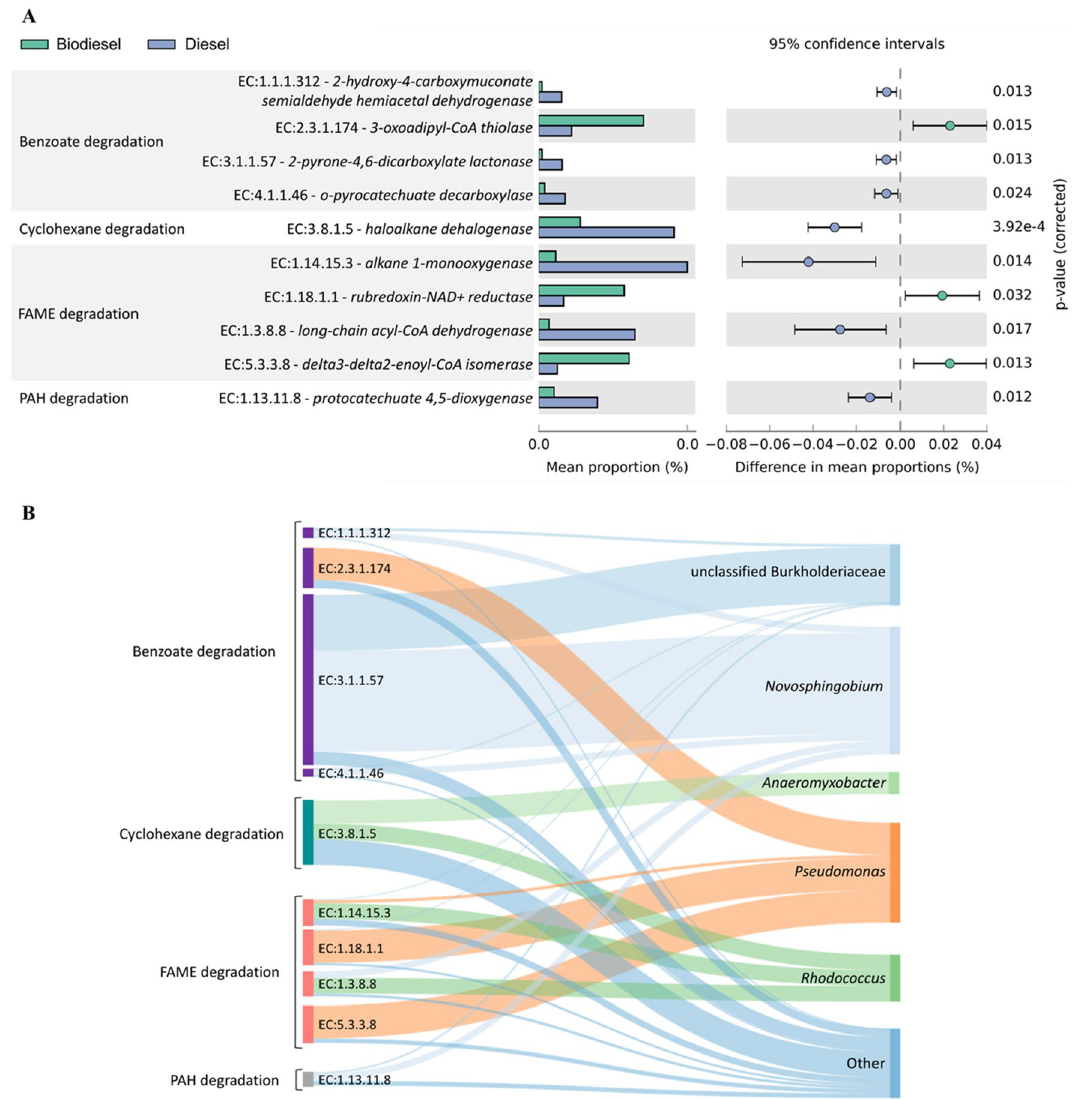
Figure 7. ( A ) PiCRUSt2 predicted hydrocarbon degrading enzymes in biodiesel and diesel amended soils. Extended bar plots represent only statistically significant microbial enzymes between treatments based on Welch’s t-test ( p < 0.05) with a minimum of 10 reads per sample. ( B ) Sankey diagram indicating the relative contribution of predicted hydrocarbon degrading enzymes (ECs) by bacterial taxa. Vertical nodes are proportional to